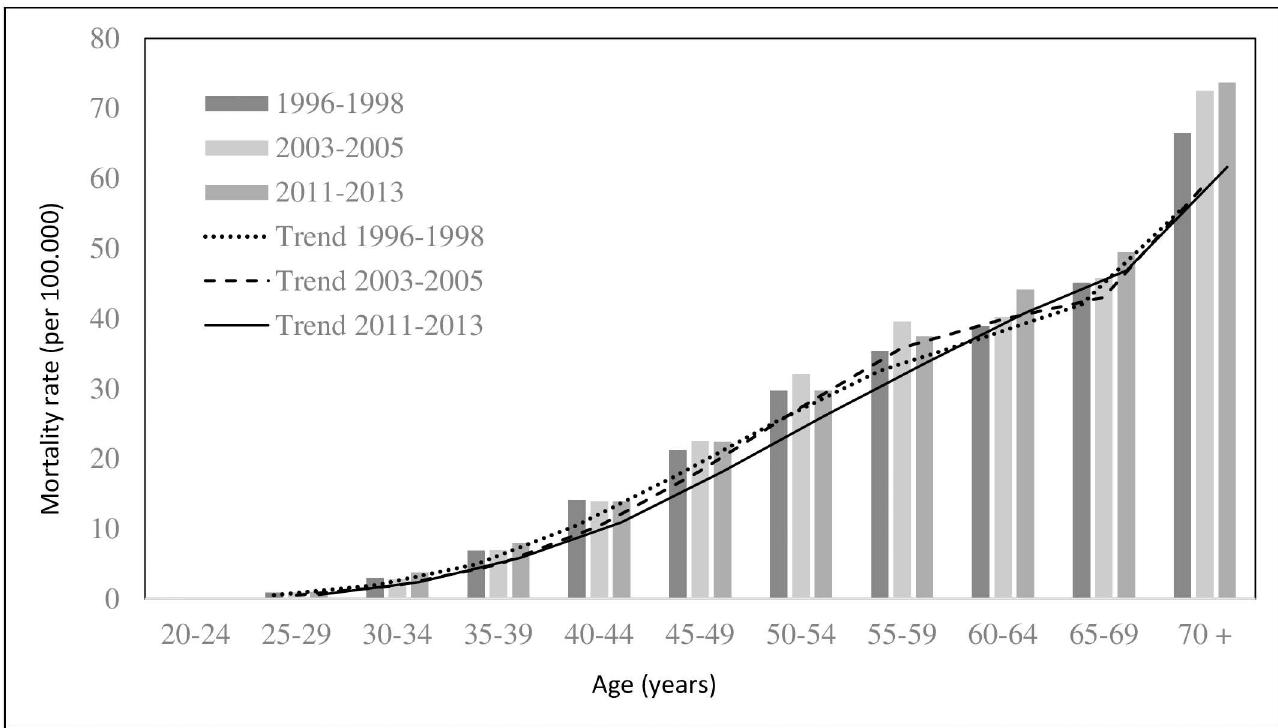
Fig 2. Breastcancer mortality in Brazil across age groups over three time periods. (A) The data of mortality from the evolutionof breast cancer in Brazil were assembled by age group along three time